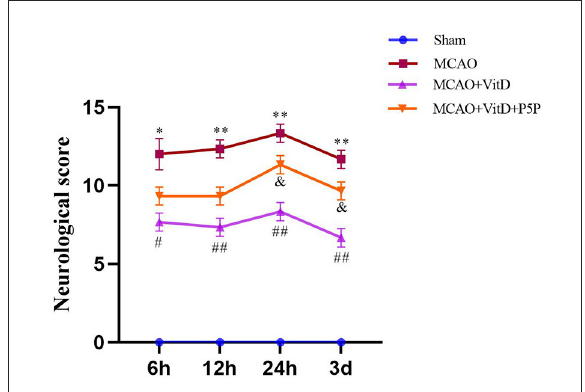
FIGURE2 Treatment with 1,25-D3 (Vit D) improved the nerve injury induced by MCAO. The modified Neurological Severity Scale scores were assessed at 6, 12, 24 h, and 3 days after reperfusion. All values are shown as the mean ± SEM, * P < 0.05, ** P < 0.01 (vs. Sham), # P < 0.05, ## P < 0.01 (vs. MCAO), & P < 0.05 (vs. VitD), n = 5. P5P, antagonist of VDR; Vit D, (1,25-D3).